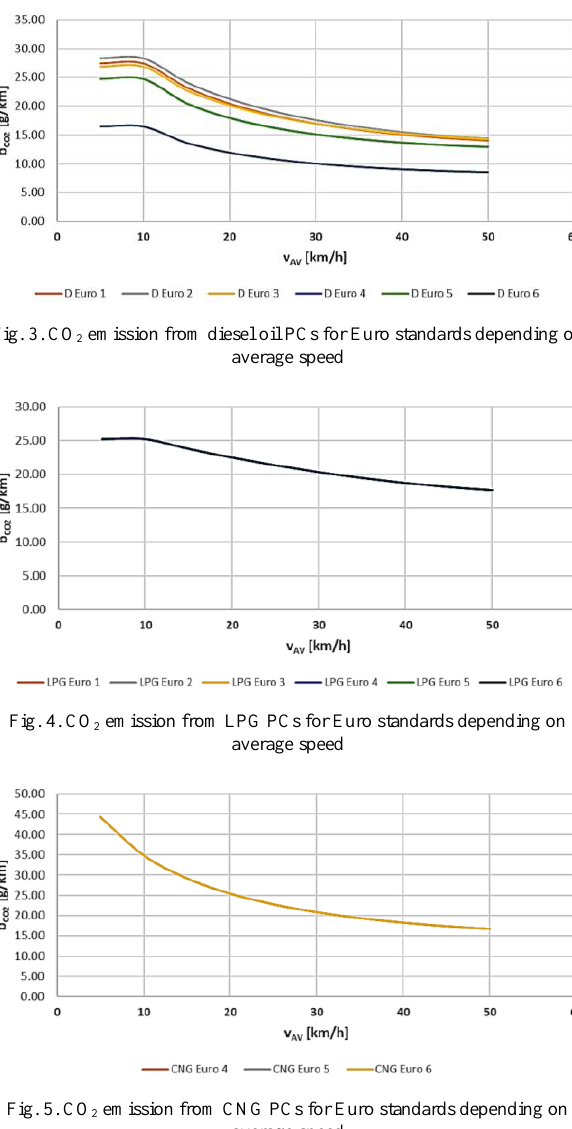
Fig. 5. CO 2 emission from CNG PCs for Euro standards depending on average speed